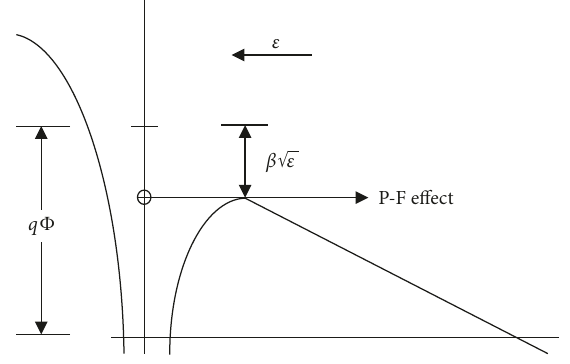
Figure 1: Coulombic potential well in the presence of an electric field illustrating the PF effect [8].